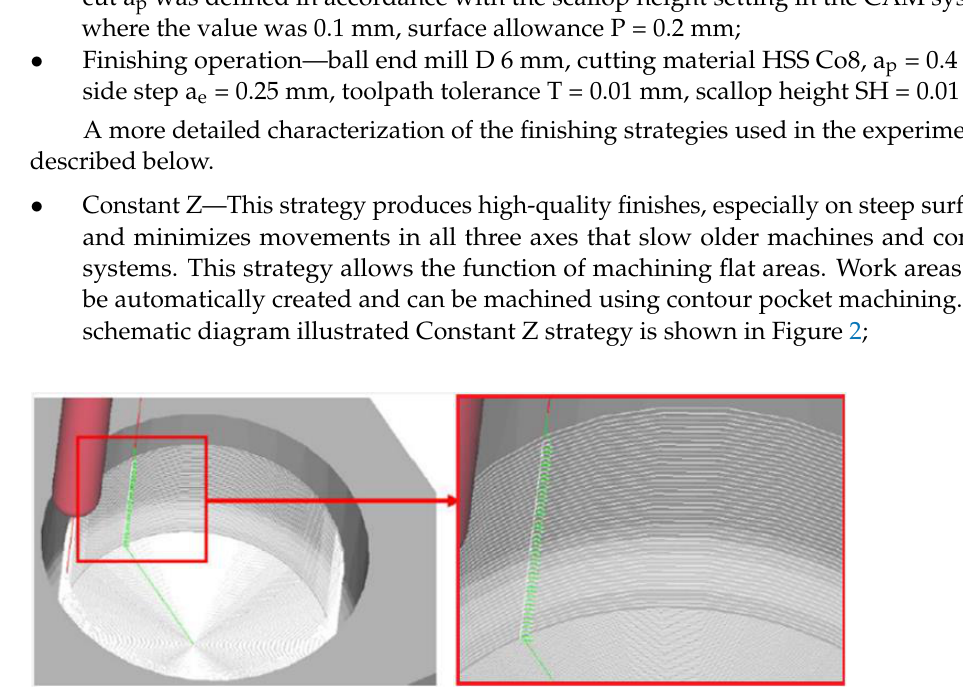
Figure 2. The schematic diagram of Constant Z strategy.